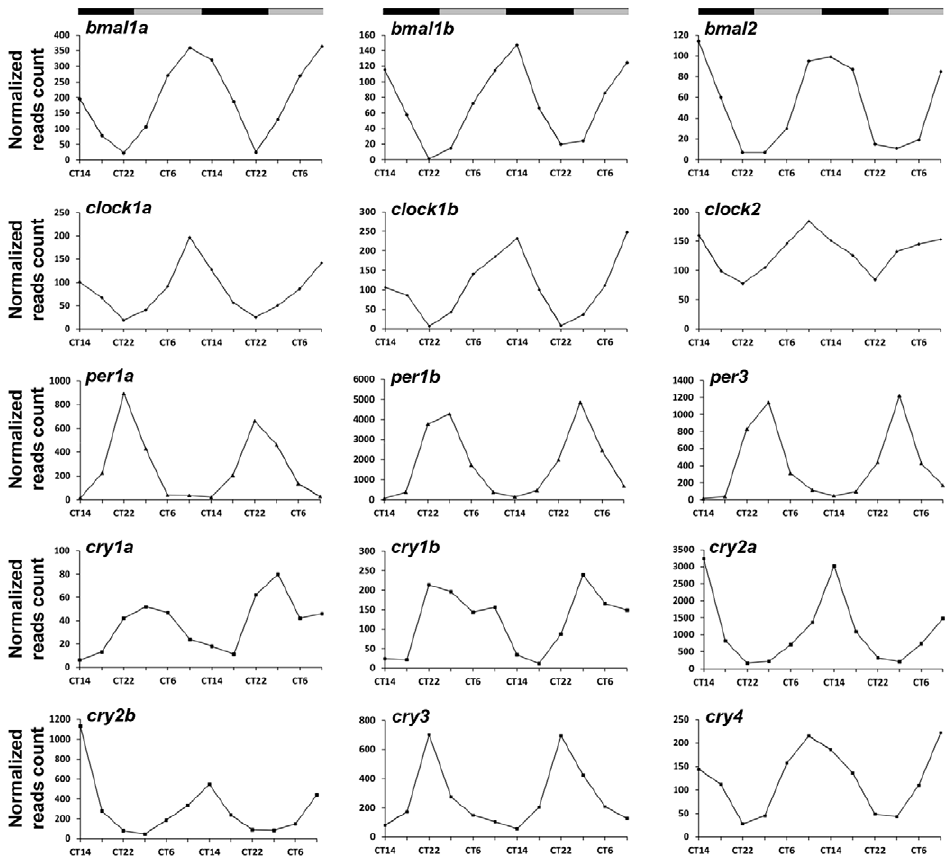
Figure 2. Circadian profiles of known core clock genes which were identified in the zebrafish pineal gland by the RNA–seq analysis. CT=circadian time. Gray and black bars represent subjective day and subjective night, respectively.